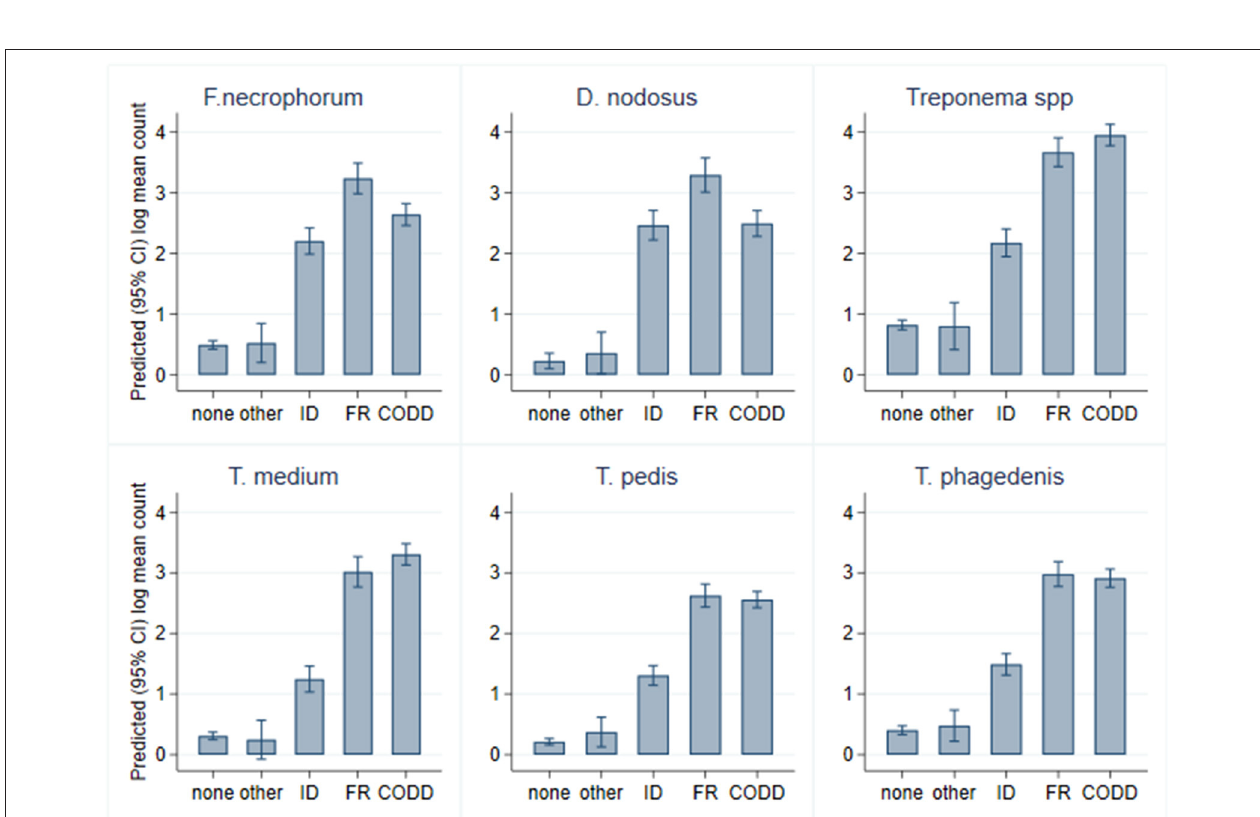
FIGURE 9 | Predicted (95% CI) mean log 10 MGCN by lesion type ( n = 30 sheep, n = 120 feet).